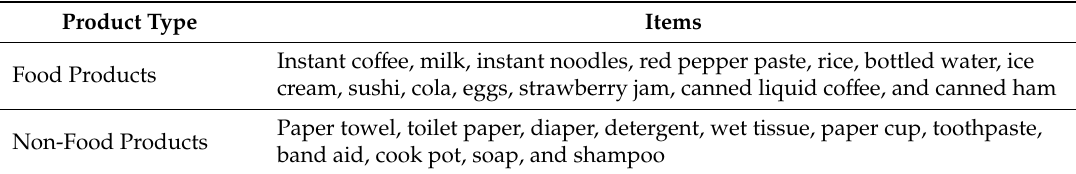
Table 5. Product type